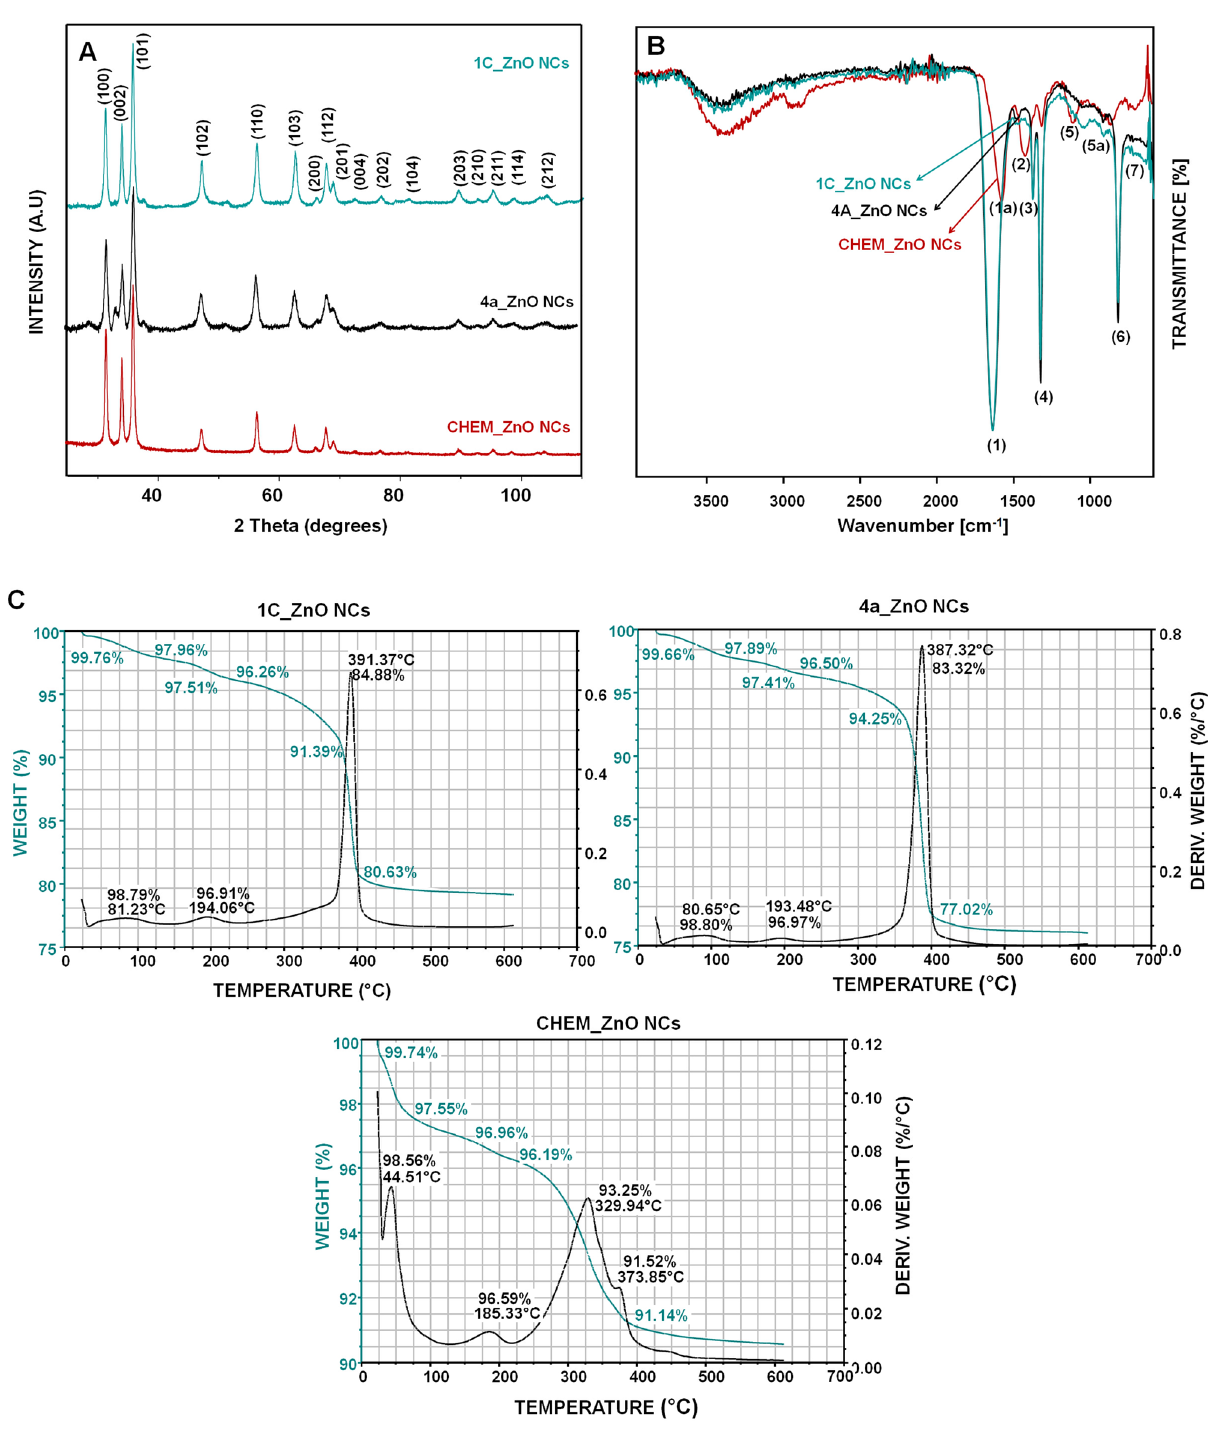
Figure 1. Physicochemical characterization of 1C, 4a and CHEM_ZnO NCs. XRD pattern ( A ); the FT-IR spectra ( B ) and the TGA/DTA pattern ( C ).